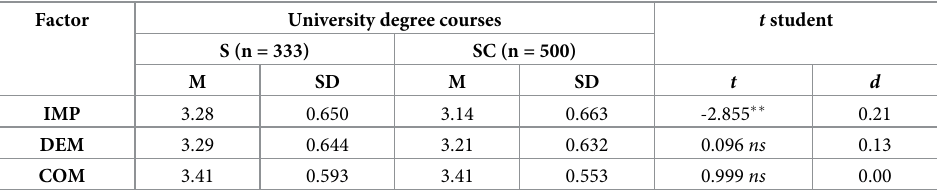
Table 6. Differences in the Q-AGT factors by university degree course.